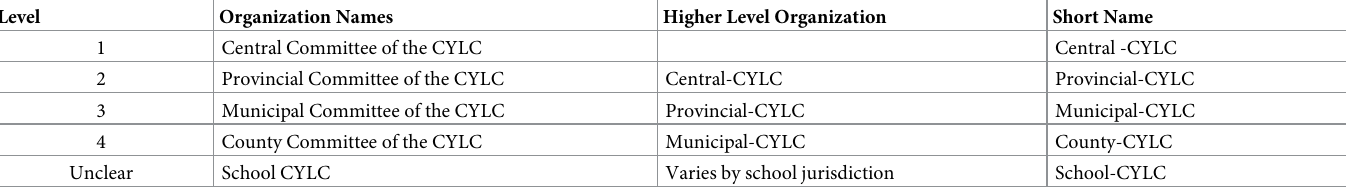
Table 1. The organizational structure of focus in this